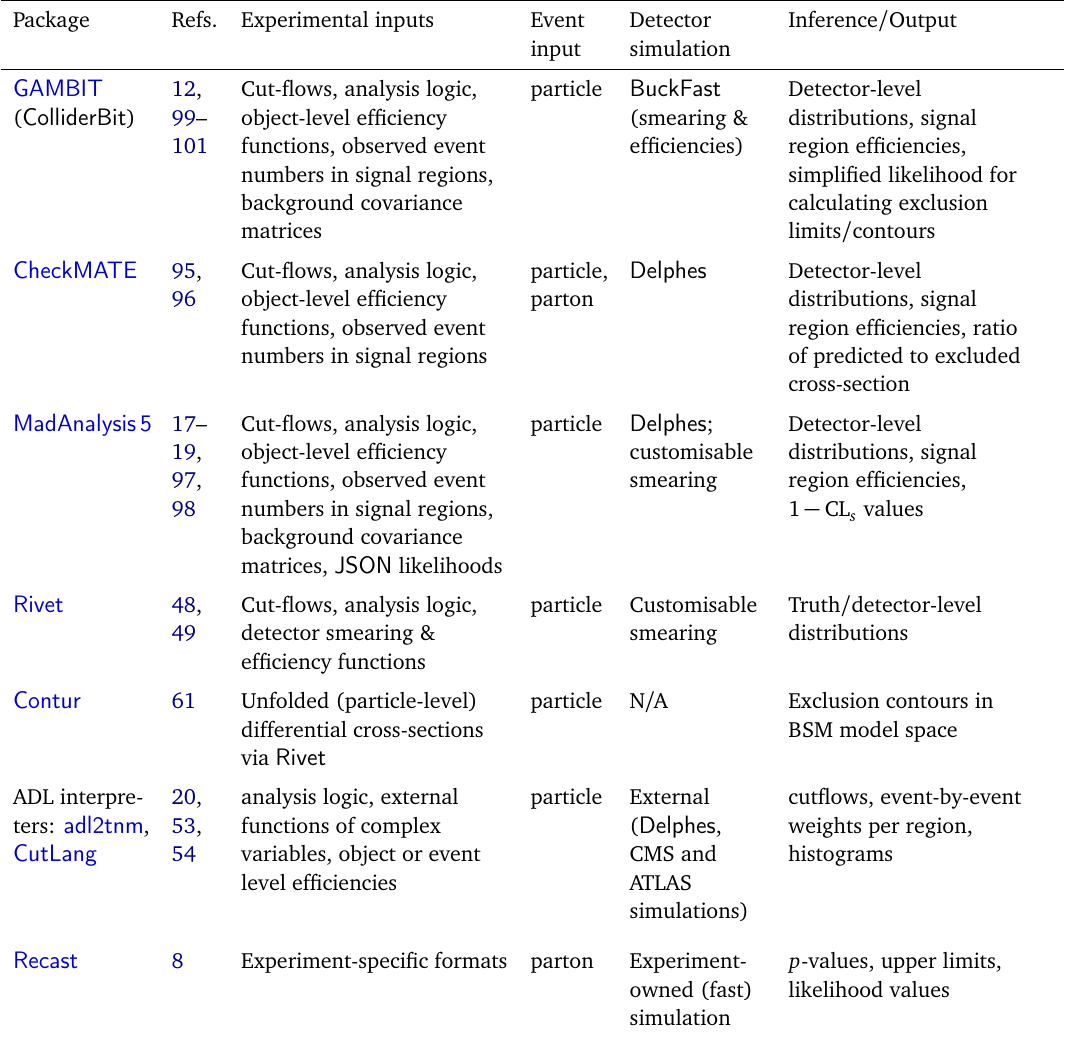
Table 1: Summary of public frameworks for the reinterpretation of searches and measurements. The columns summarise the major inputs from the experiments used for the reinterpretation, how detector effects are modelled (if necessary) and the principle outputs in terms of performing statistical inference. Particle-level inputs specifically refer to files in HepMC format, whereas parton-level inputs specifically refer to LHE files (except in the case of Recast , which can also accept other internal ATLAS parton-level